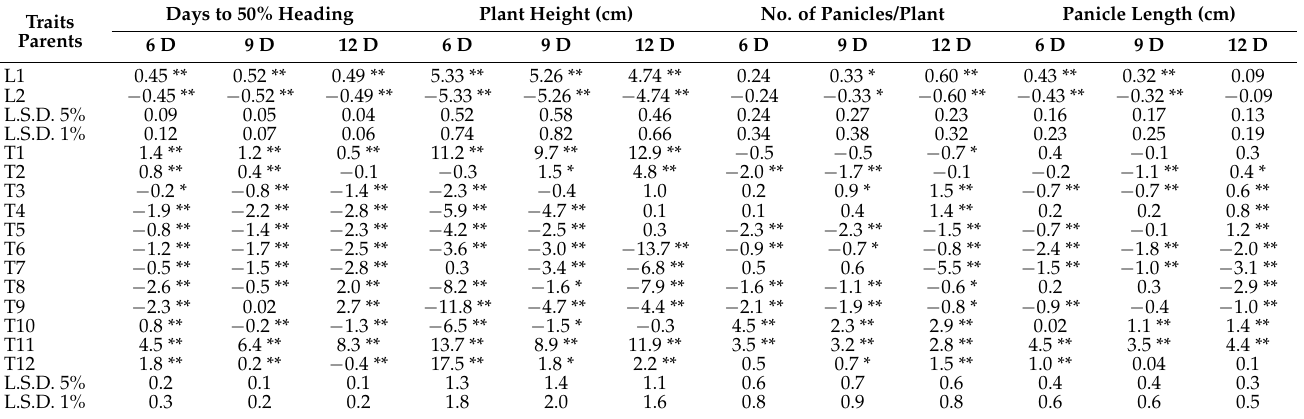
Table 5. General combining ability effects of the parental lines for days to 50% heading, plant height, no. of panicles/plant and panicle length traits.